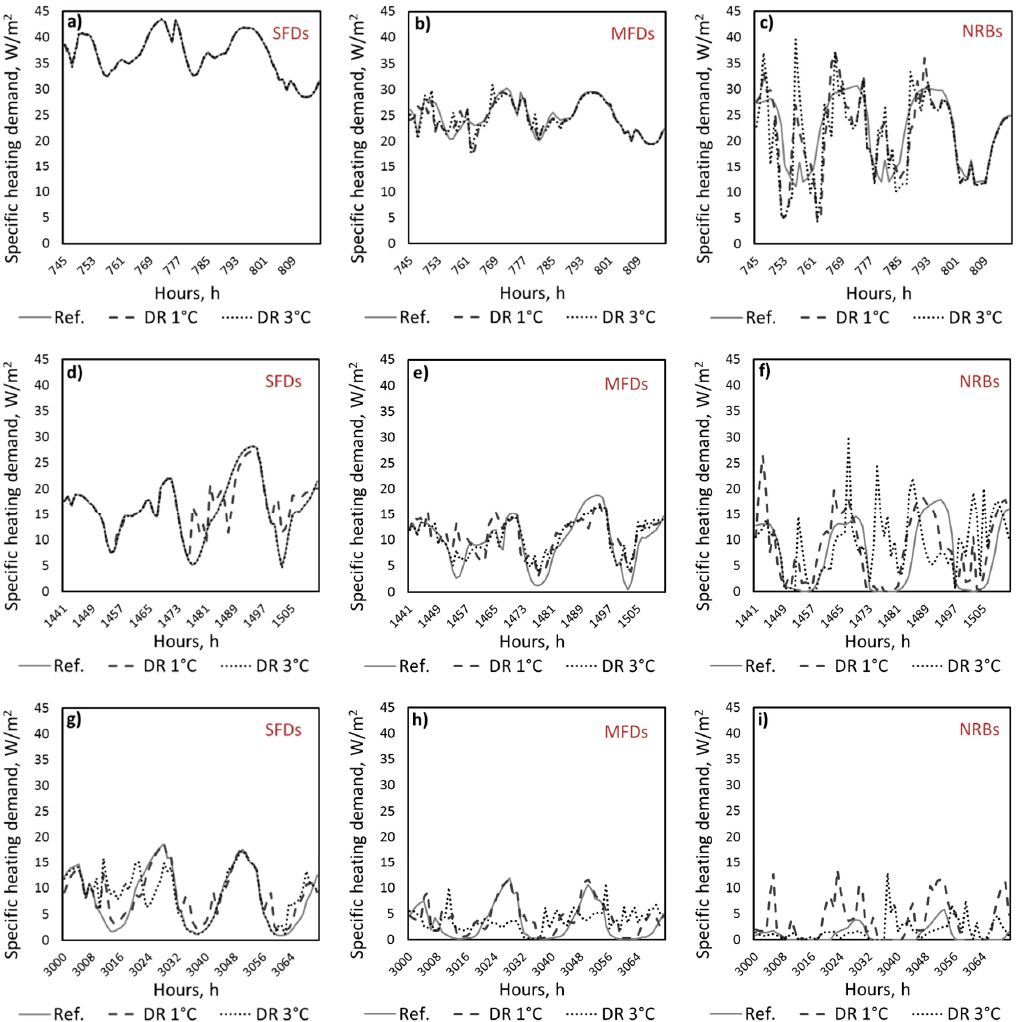
Figure 6. Specific (W / m 2 ) hourly heating demand profiles of the SFDs, MFDs, and NRBs connected to the DH system of the City of Gothenburg, as obtained from the modeling for the Reference, DR 1 ◦ C, and DR 3 ◦ C scenarios. The profiles are shown for 3 days in: February, with average outdoor temperature of − 10.7 ◦ C ( a – c ); March, with average outdoor temperature of 3.8 ◦ C ( d – f ); and May, with average outdoor temperature of 7 ◦ C ( g – i ), all in 2012.